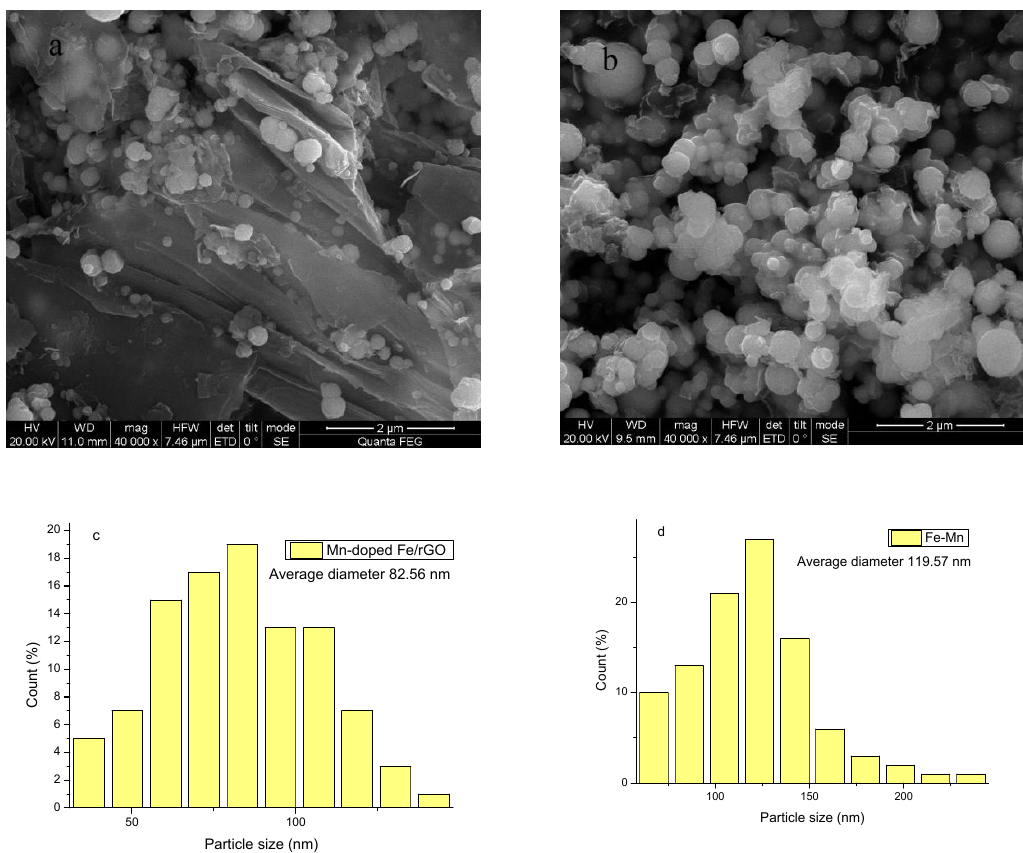
Figure 5. SEM image and the corresponding particle size of Mn-doped Fe / rGO ( a , c ) and Fe–Mn ( b , d